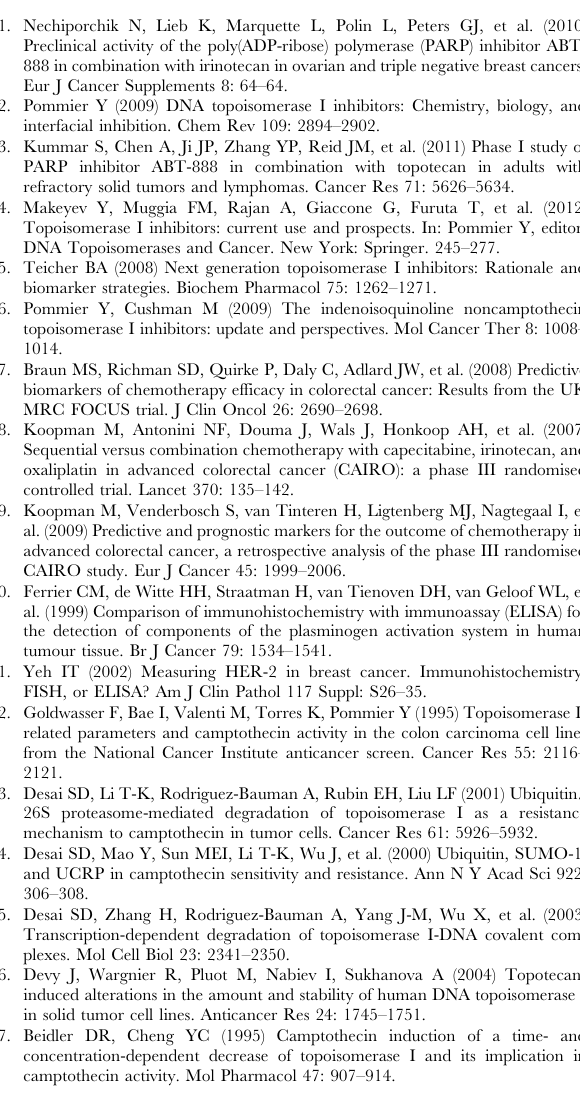
Figure S1 Western blot analysis of Top1 levels in topotecan-responsive and –nonresponsive cell lines.